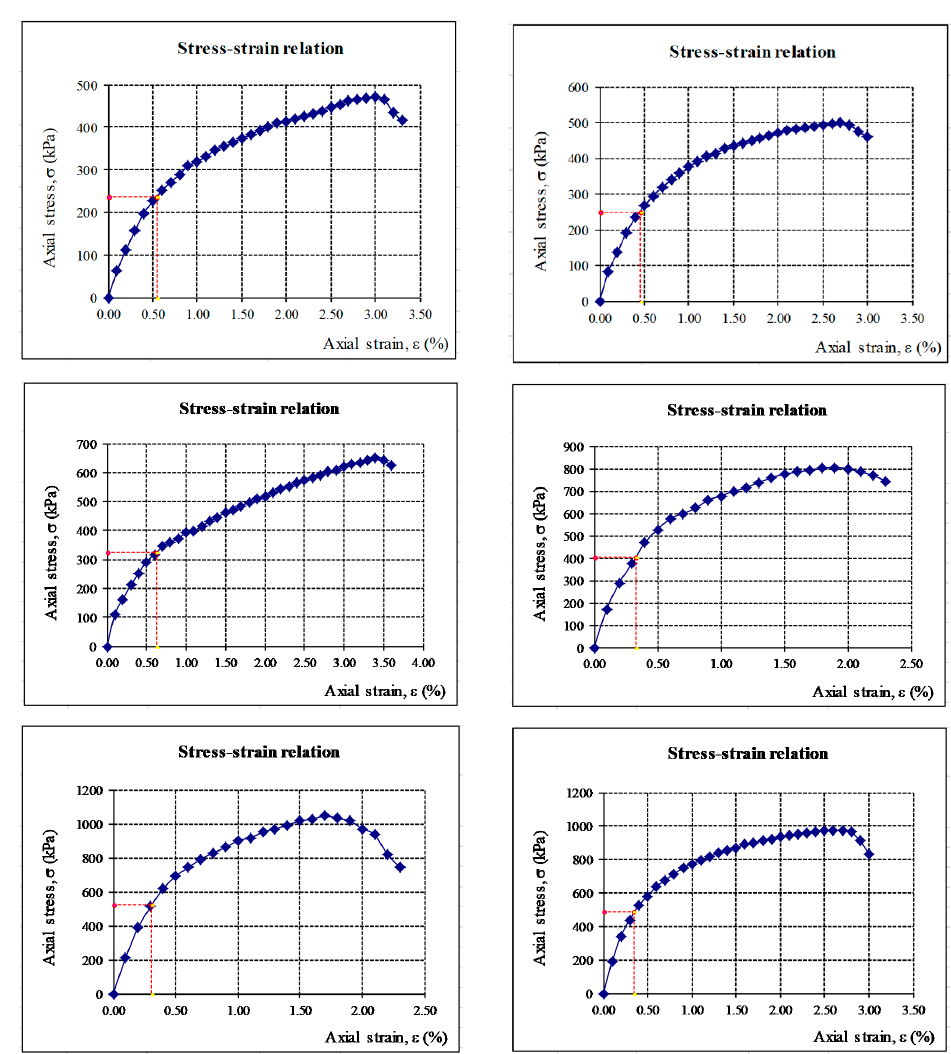
Figure A1. An example of some axial stress–strain relation curves of the soil–cement mixture.